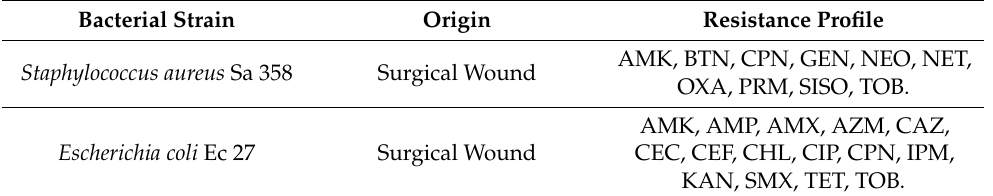
Table 5. Bacterial origin and antibiotic resistance